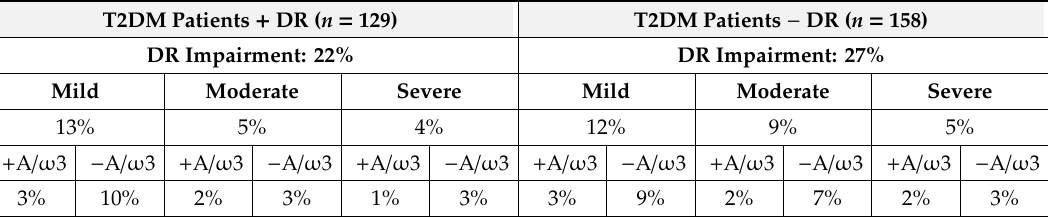
Table 4. Diabetic Retinopathy course through the 38-months of follow-up. T2DM Patients + DR ( n = 129) T2DM Patients − DR ( n =